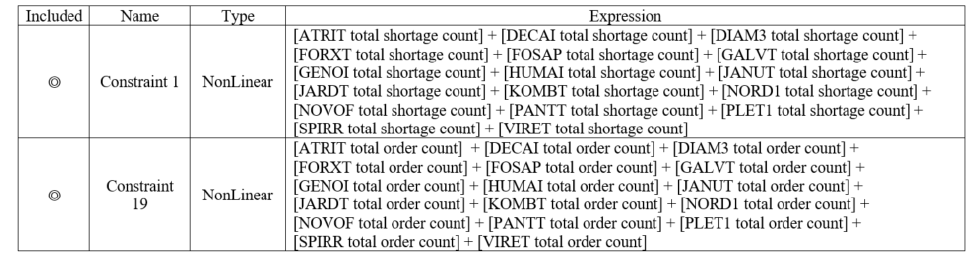
Figure 15. Setting values of constraints for Group 1 in Scenario 3.